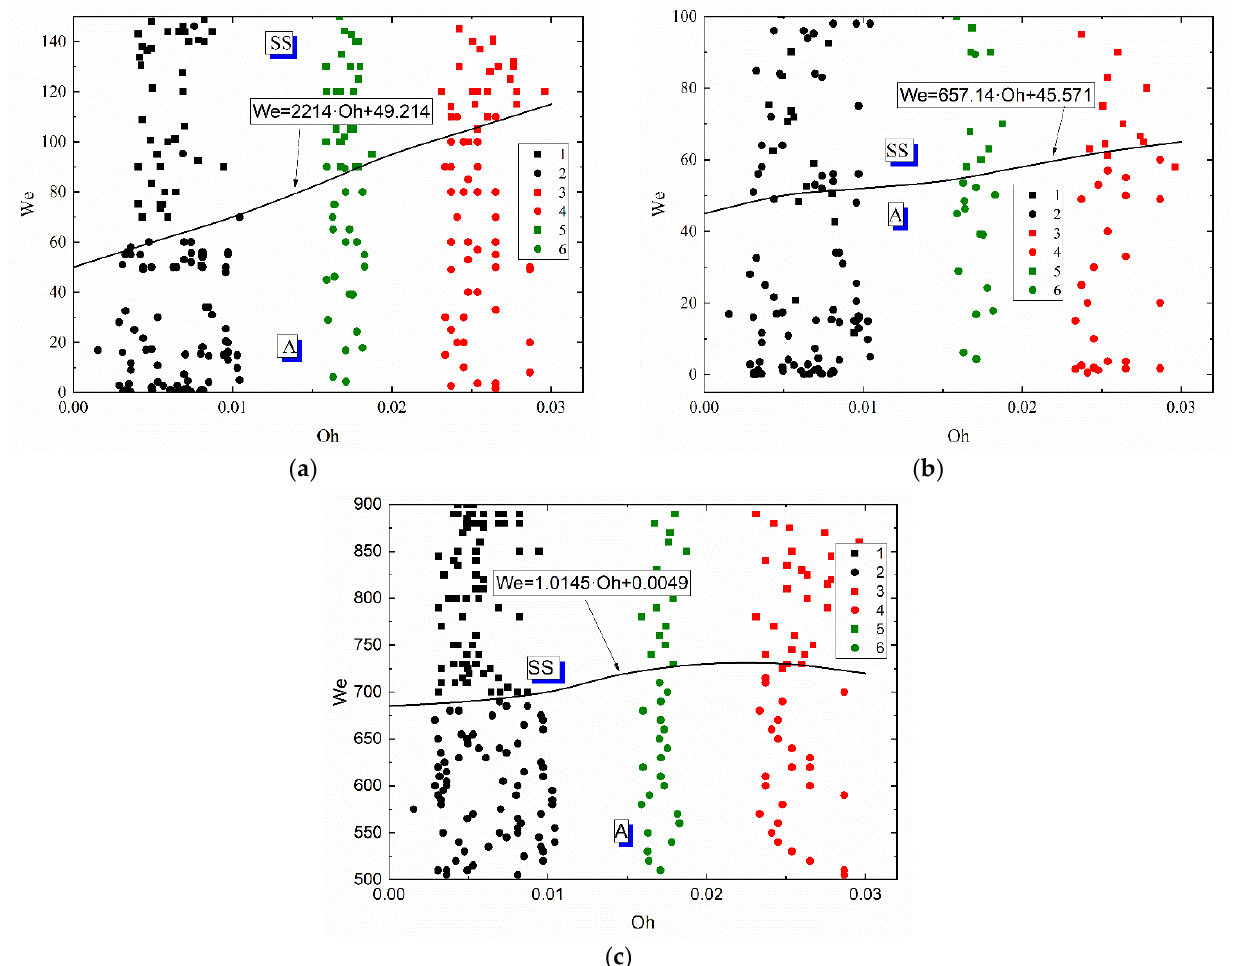
Figure 10. Effect of liquid properties on the transition boundary between agglomeration and stretch- ing separation during the collision of a droplet with a particle ( a ), with another droplet ( b ) [45] and with a solid substrate ( c ): 1, 2—water; 3, 4—50 vol% water and 50 vol% glycerol; 5, 6—10 vol% water and 90 vol% diesel; 1, 3, 5—stretching separation; 2, 4, 6—agglomeration.